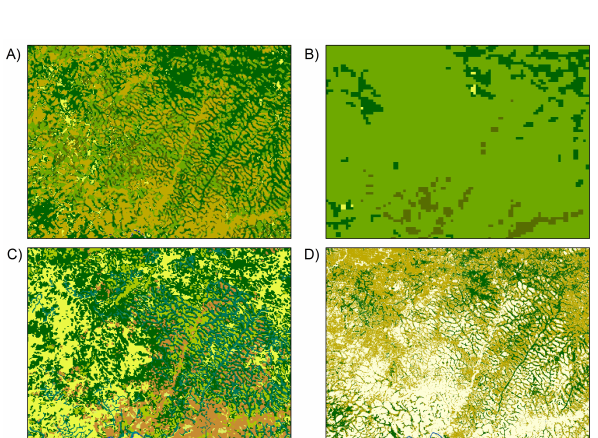
Fig. 8. Visual comparison of the new Congo Basin vegetation map with earlier maps in a forest/savanna zone in Haut-Uele (Zigbi). (A) Congo Basin Vegetation types map. (B) GLC 2000 (1 km res- olution). (C) GlobCover (300m resolution). (D) DRC Facet Atlas (OSFAC, 2010).